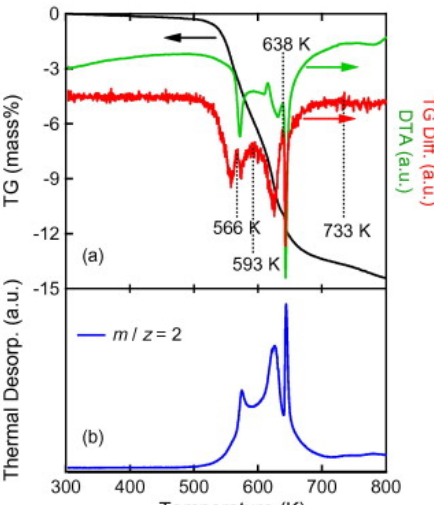
Figure 4. TG-DTA and mass spectrum curves of the thermal desorption of Mg(BH 4 ) 2 : ( a ) the thermogravimetry curve (black), its derivative (red) and the differential thermal analysis (green) curves of Mg(BH 4 ) 2 ; and ( b ) associated mass spectrum of the as-synthesised Mg(BH 4 ) 2 (blue). Reprinted from